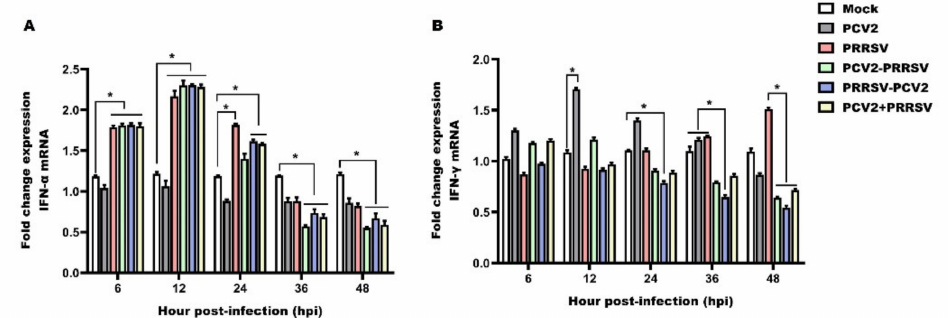
Figure 4. Relative mRNA expression of IFN- α and IFN- γ . PAMs in the PCV2 alone group (PCV2), the PRRSV alone group (PRRSV) and the PCV2 and PRRSV co-infected groups (PCV2–PRRSV, PRRSV– PCV2 and PCV2 + PRRSV) were inoculated with PRRSV or/and PCV2 at a MOI of 1, respectively. PAMs in the mock group were inoculated with equal RPMI-1640 medium. Then, PAMs from these groups were collected at 6 h, 12 h, 24 h, 36 h and 48 h post-infection, respectively. RT-qPCR analysis of IFN- α ( A ) and IFN- γ ( B ) mRNAs in PAMs from different groups. Data are expressed as means ± SD of three independent experiments. Significant differences between groups are represented (* p <